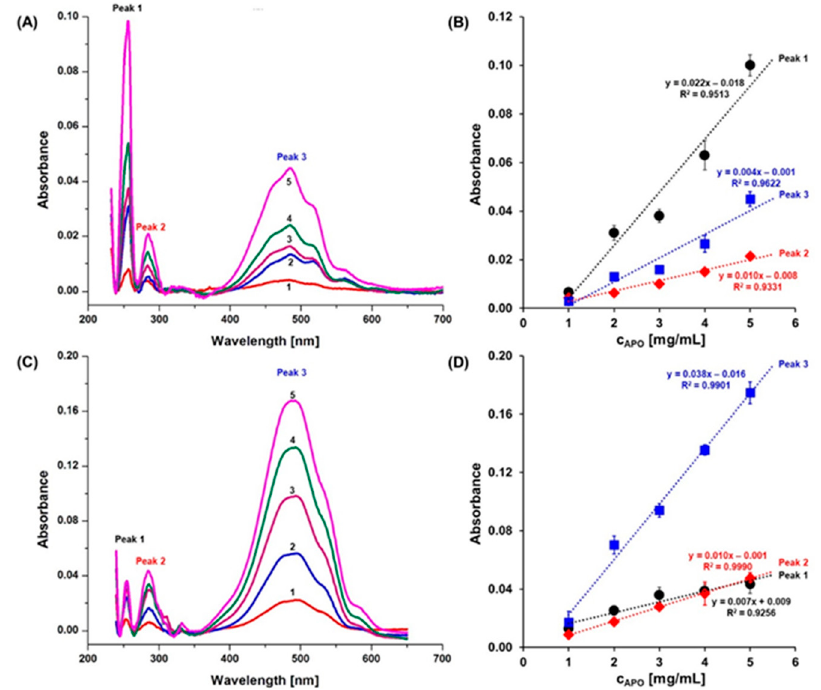
Figure 2. The UV-Vis spectra for solutions of: ( A ) APO(IDA) and ( C ) APO(DOX) nanocarriers, for increasing concentrations of APO nanocages [mg/mL]: (1) 1; (2) 2, (3) 3, (4) 4, (5) 5. ( B , D ) Dependences of the peak absorbance intensities vs. APO concentration for: ( B ) APO(IDA) and ( D ) APO(DOX) nanocarriers for peak P1 at 255 nm, peak P2 at 280 nm, and peak P3 at 485 nm. Samples were diluted 1:10 with Milli-Q water. Data are expressed as mean ± SD ( n = 5) and the values of correlation coefficient R for linear fitting are printed at the curves.